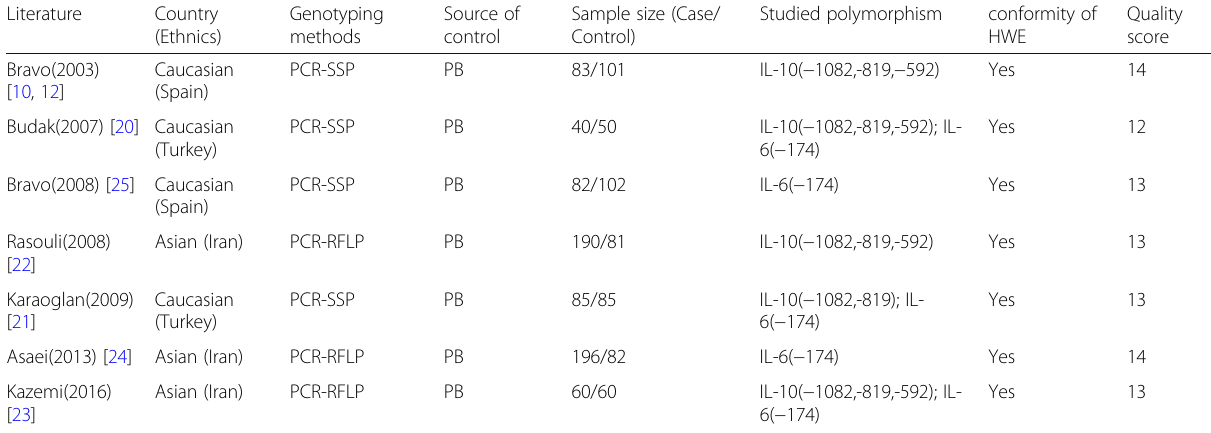
Table 2 Characteristics of studies included in this meta-analysis